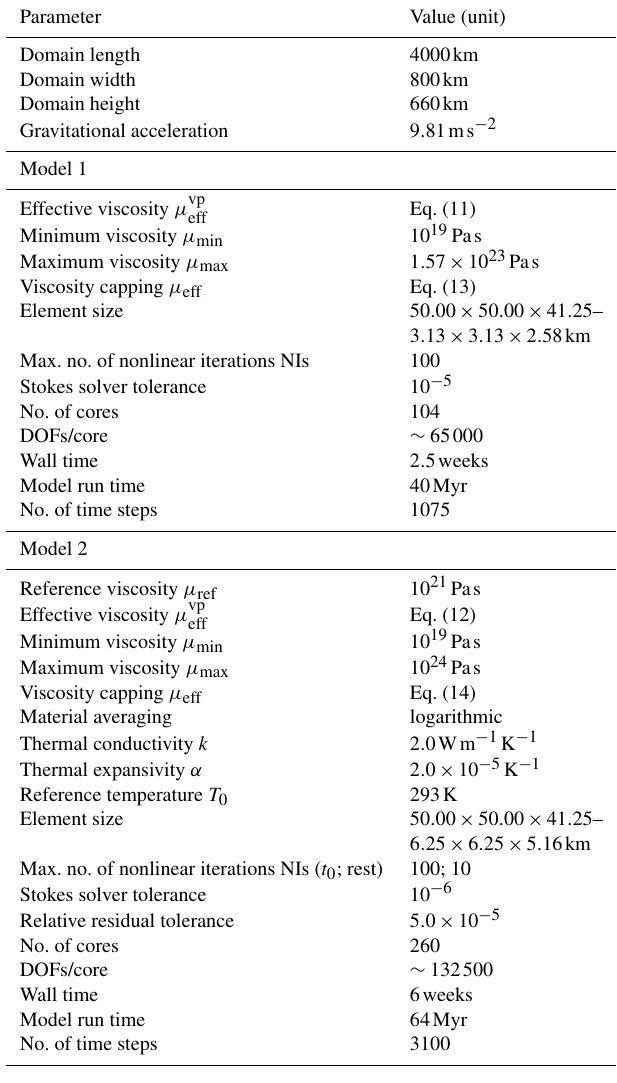
Table 7. Three-dimensional subduction model